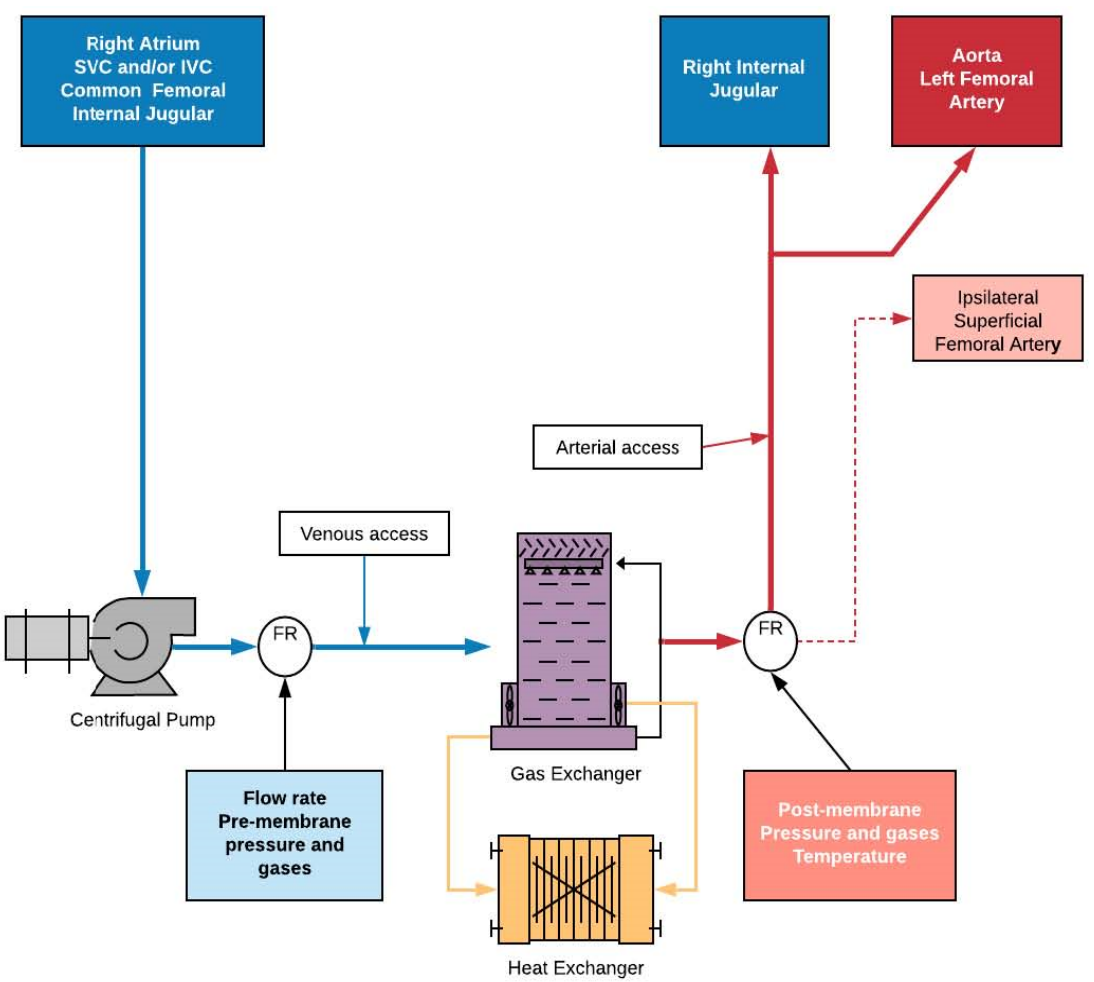
Figure 1. Sample VV ECMO circuit and possible cannulation sites.